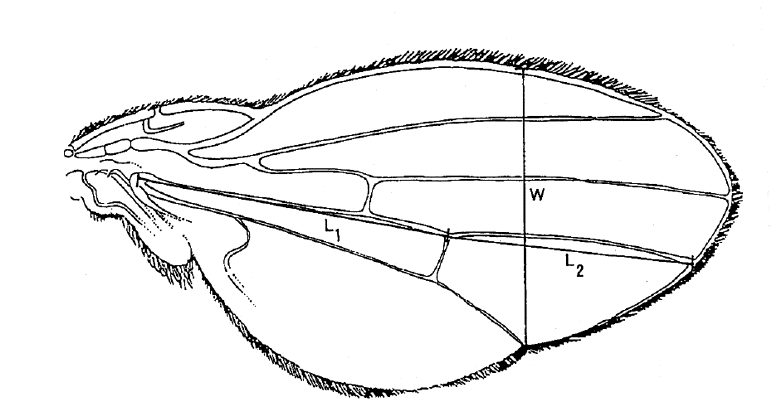
Figure 1 - Continuous variables measured in the wing of D. subobscura (L for details.